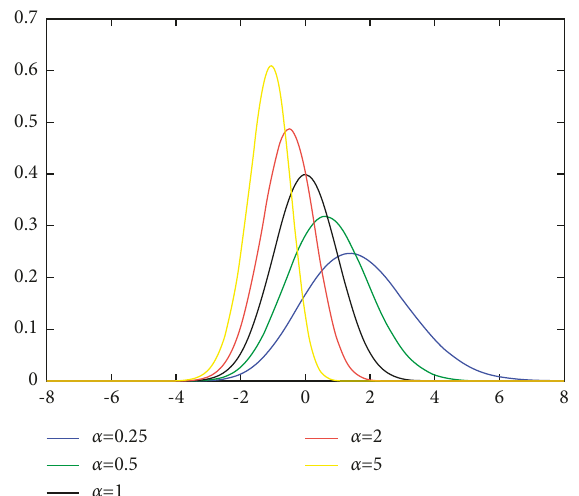
Figure 1: The pdf of skew-normal distribution for different values of α